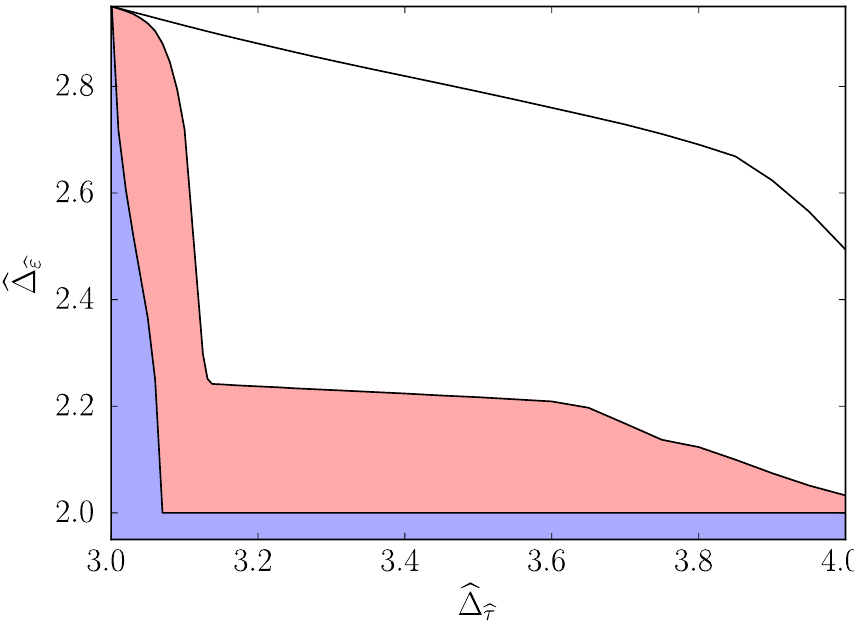
Figure 1. A plot showing the upper bound on the dimension of the identity, seen by any of the OPEs in our correlator system. The unshaded region is the one that follows from a single correlator the multi-correlator system but the only inputs it uses from the exact relations are the odd-spin operator dimensions given in table 1. The blue region, more restrictive again, follows from a genuine use of the exact relations. Since these depend on a is not